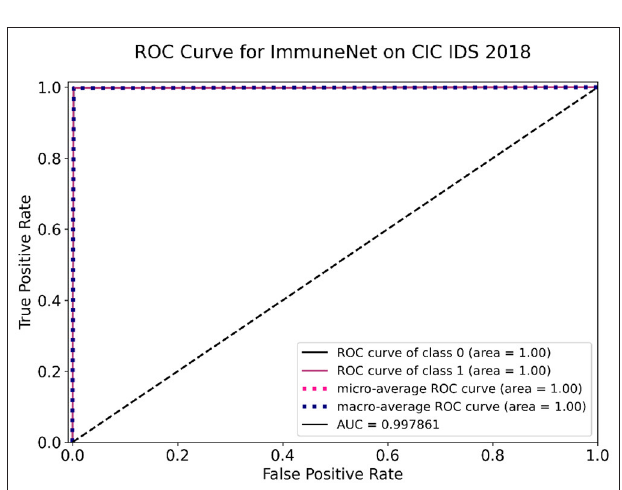
FIGURE 13 | Receiver operating characteristic (ROC) curve of ImmuneNet on CIC IDS 2018